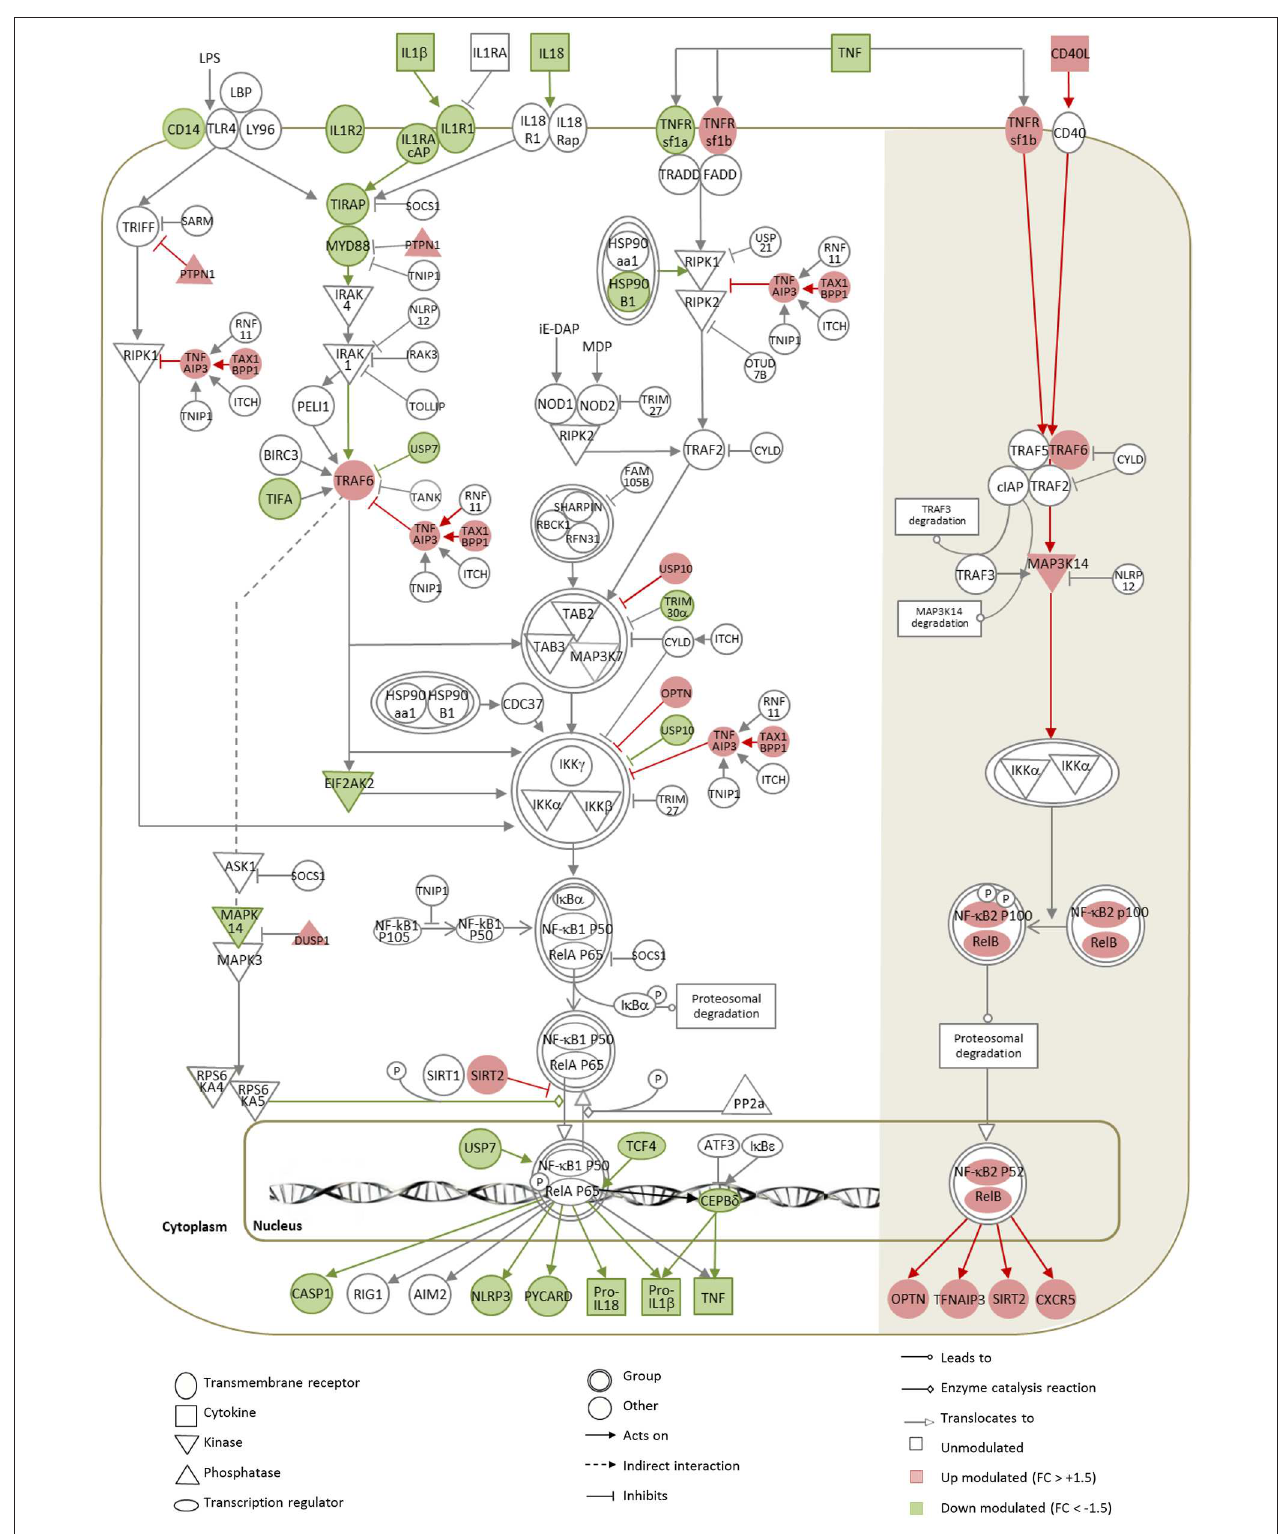
FIGURE 6 | Gene expression map of the NF- κ B pathway in DCs infected with Ab-opsonized amastigotes. Significant modulations calculated between L.am -IS-infected and uninfected BMDCs are represented by the color code, with red indicating up-regulated (linear FC > + 1.5) and green down-regulated (linear FC < -1.5) genes. Symbols, lines, and color codes are defined in the legend. White (left) and shaded (right) areas correspond to the classical and to the alternative NF- κ B pathways, respectively.